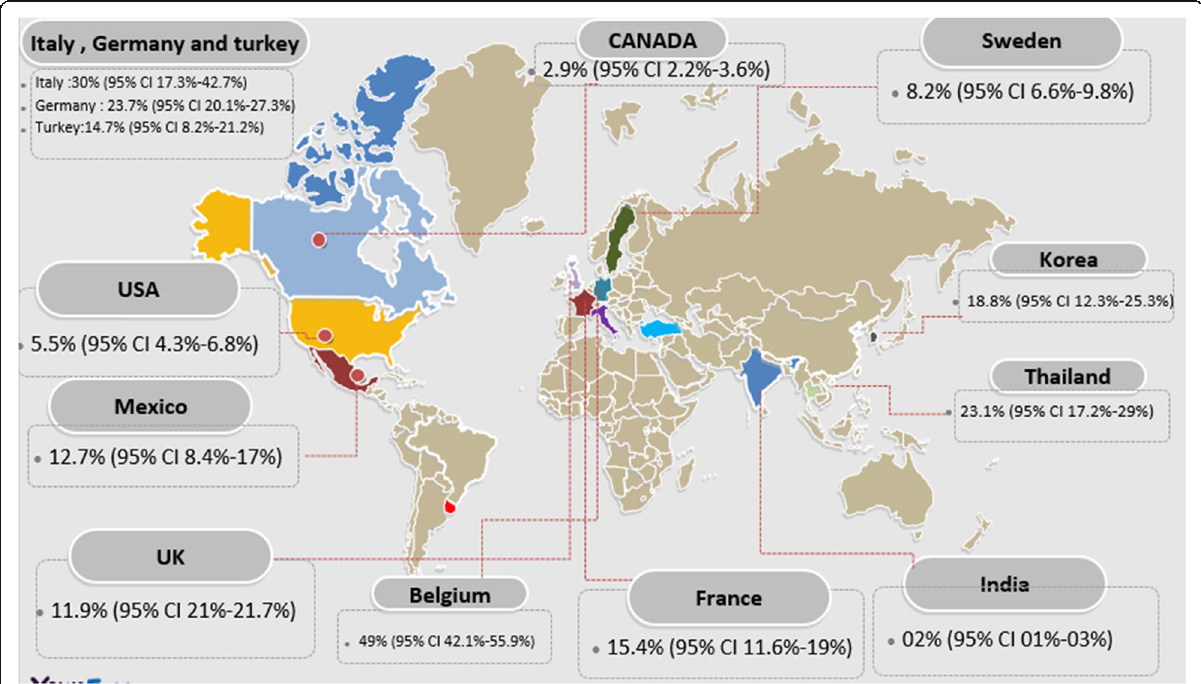
Fig. 7 Prevalence of epilepsy surgery complications based on